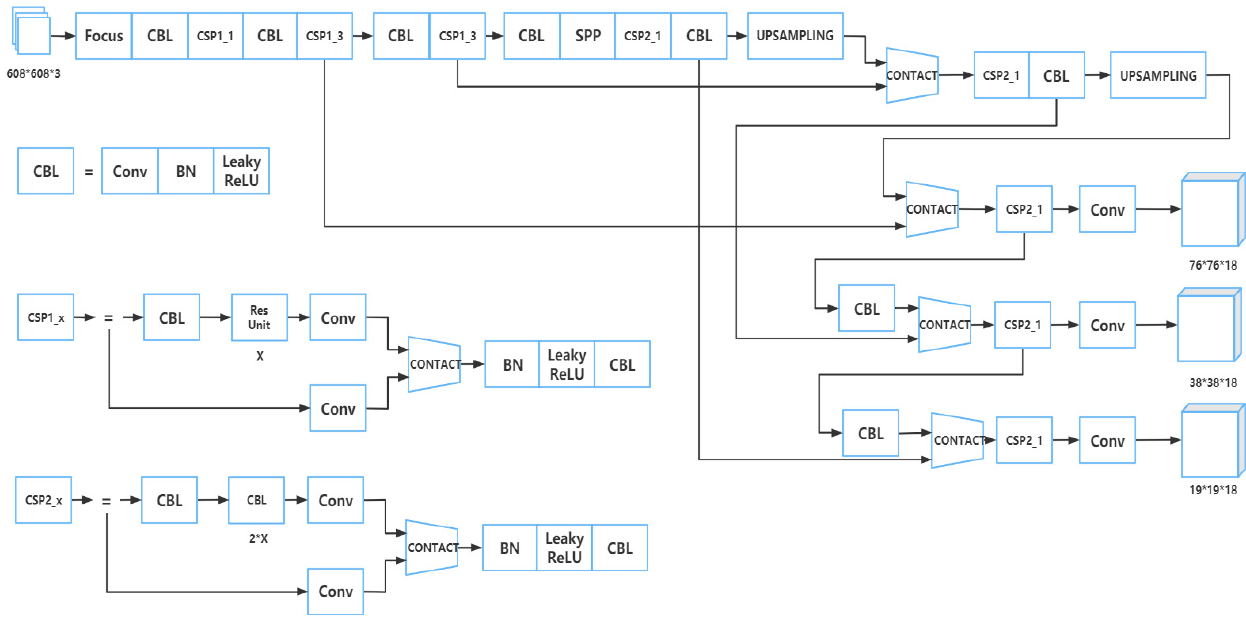
Figure 4. Network structure diagram of YOLOv5.